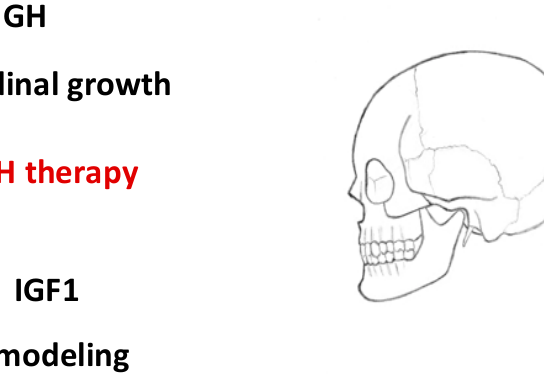
Figure 1. Association between longitudinal cranial bone growth, remodeling, and rHGH therapy. The therapy of rHGH impacts the growth of the skull in a dual mechanism: by longitudinal growth of bones under GH influence and by remodeling of bones under IGF1 action.